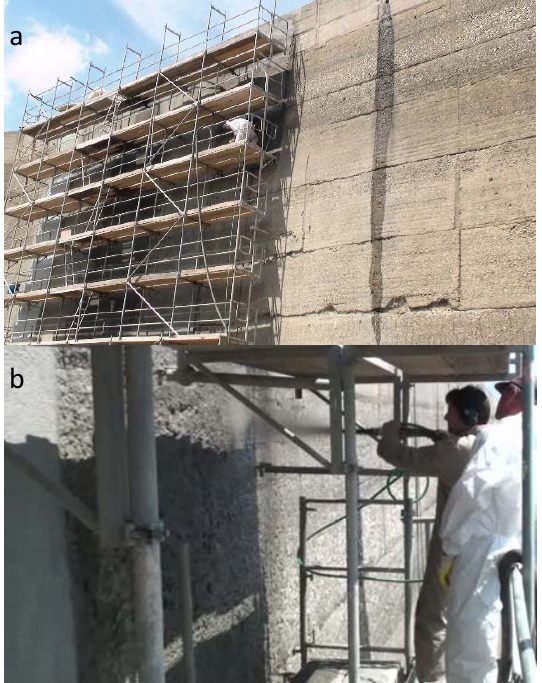
Dresden was used to repair the upper water reservoir of the pumping hydraulic power station Hohenwarte II in Thüringen, Germany, see Fig. 7. Since the reservoir walls are exposed to high water saturation and considerable changes in water level, the danger of frost damage is considerable. In practice the use of conventional air ‐ entrainment agents is possible with SHCC, but not when the spraying technique is applied. For this reason SAP was introduced as a new additive to improve the frost resistance of the repair